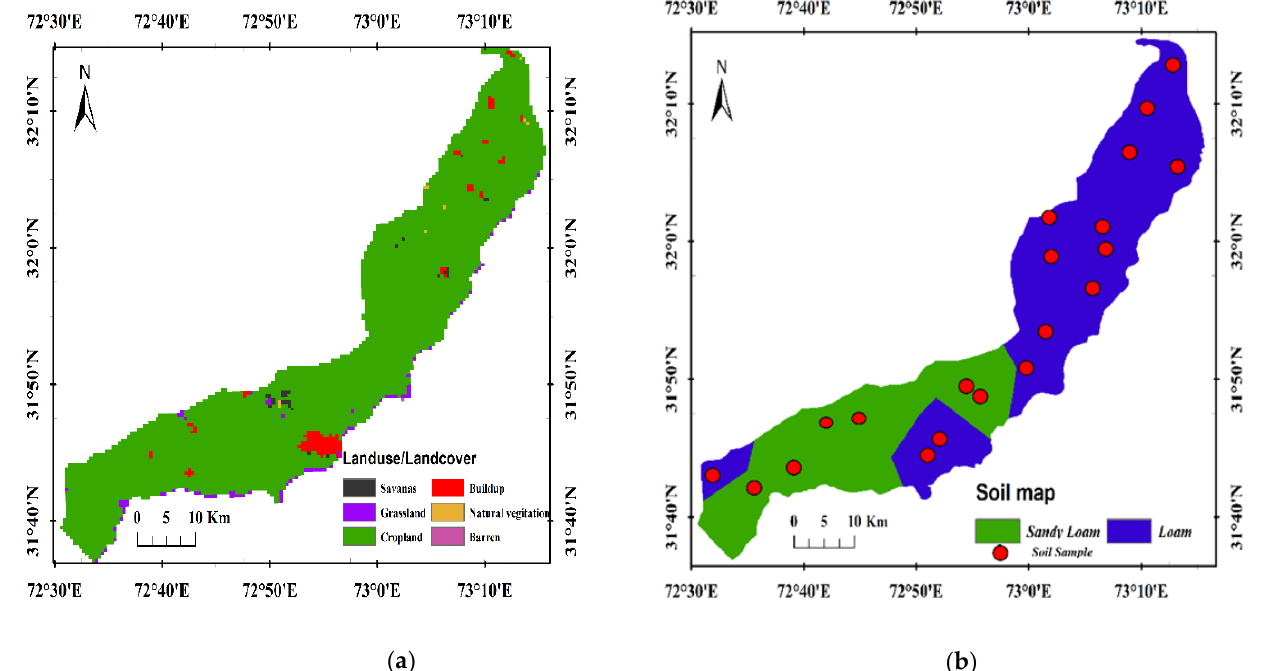
Figure 4. Input data for the model, ( a ) land use/land cover and ( b ) soil texture. Meteorological Data Collection